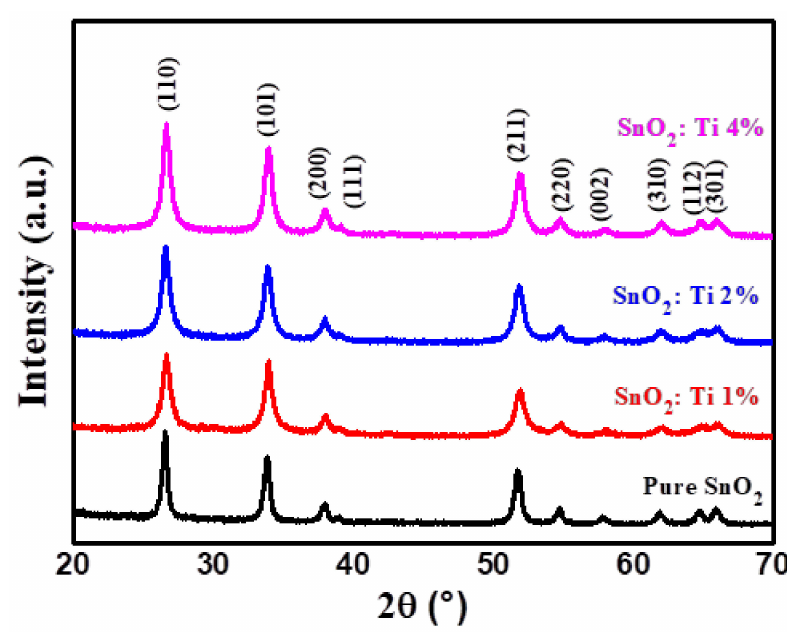
Figure 3. X-ray diffraction of Ti–SnO 2